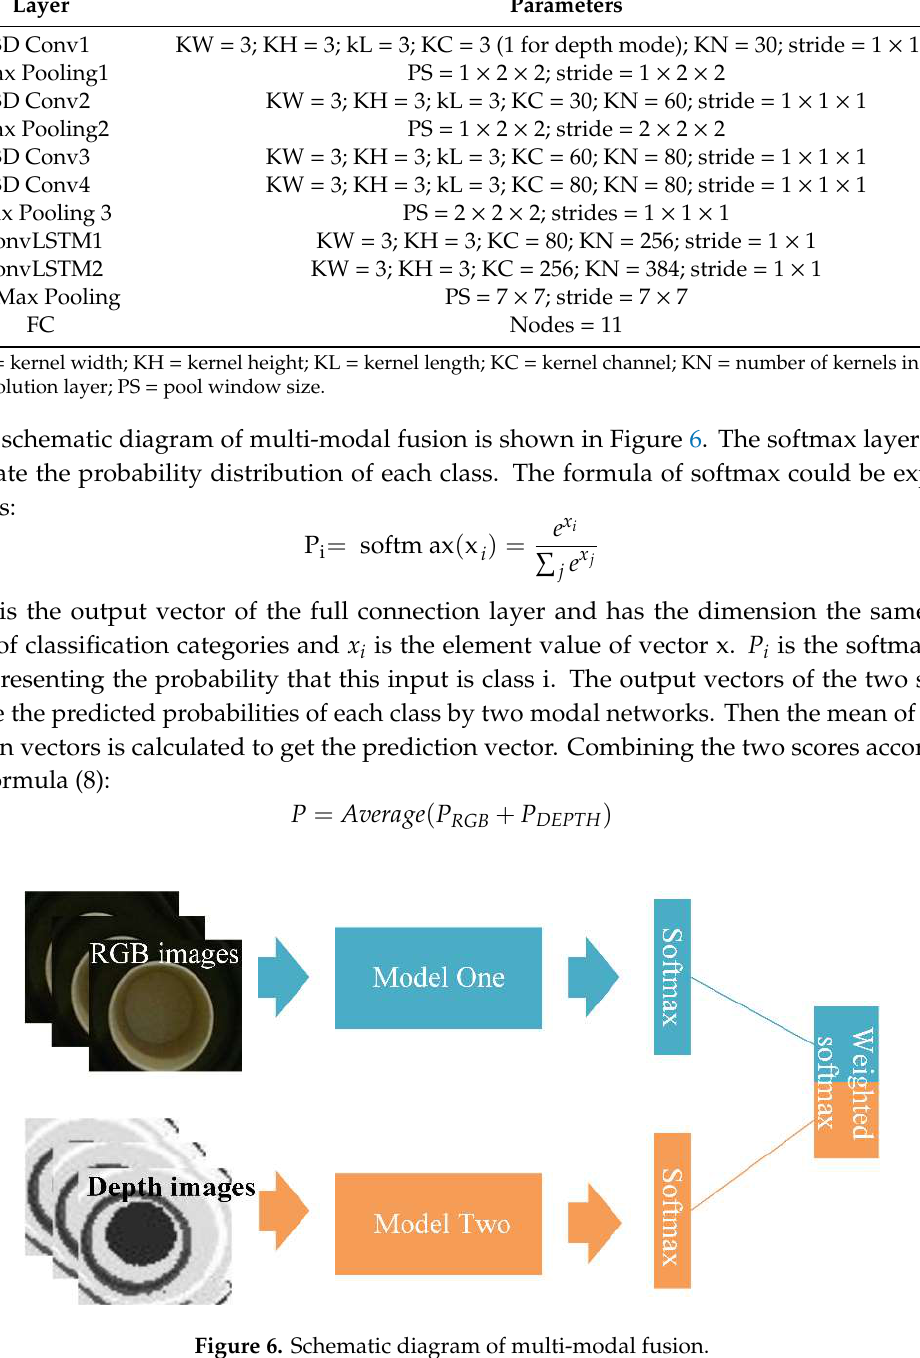
Figure 6. Schematic diagram of multi-modal fusion.